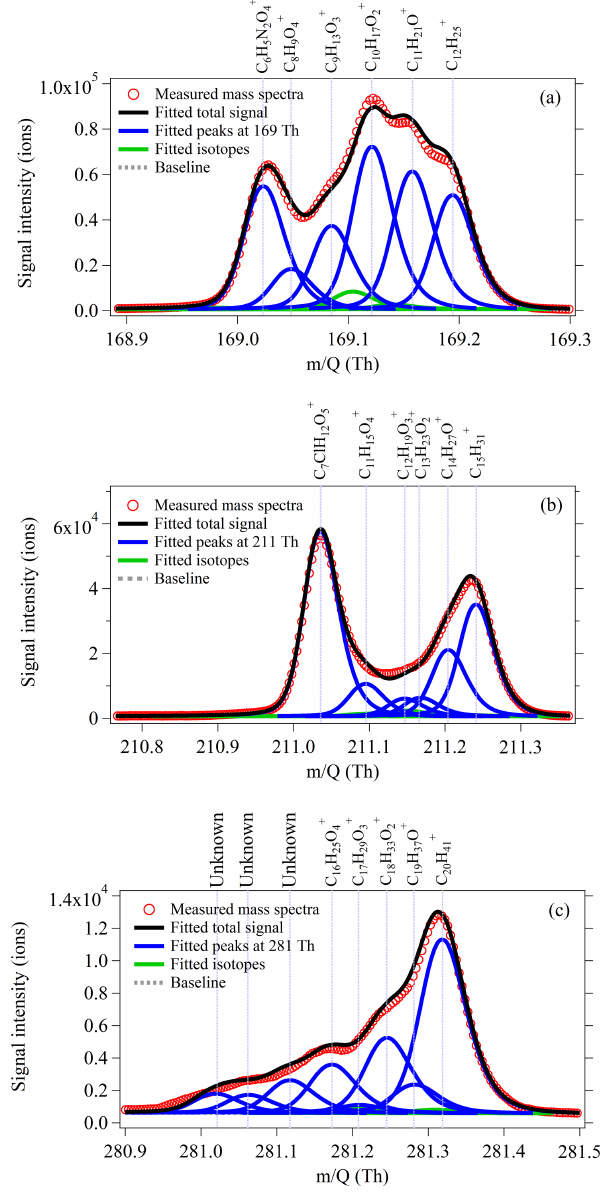
Figure 1. High-resolution (HR) peak fitting to the averaged mass spectra on a typical day (12 October 2018) for m/z 169 (a) , m/z 211 (b) , and m/z 281 (c) , at which masses produced by do- decane (C 12 H + ), pentadecane (C 15 H + ), and eicosane (C 20 H + ) 25 31 41 are detected using NO +